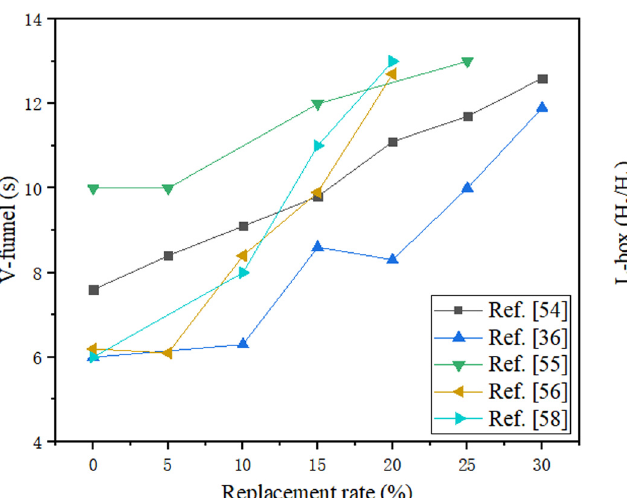
Figure 4: V - funnel test of RHA – SCC [ 36,54 – 56,58 ]